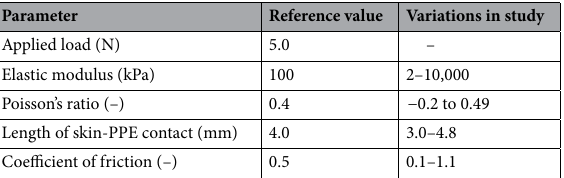
Table 1. The mask material, geometry and interfacial properties that were varied in this